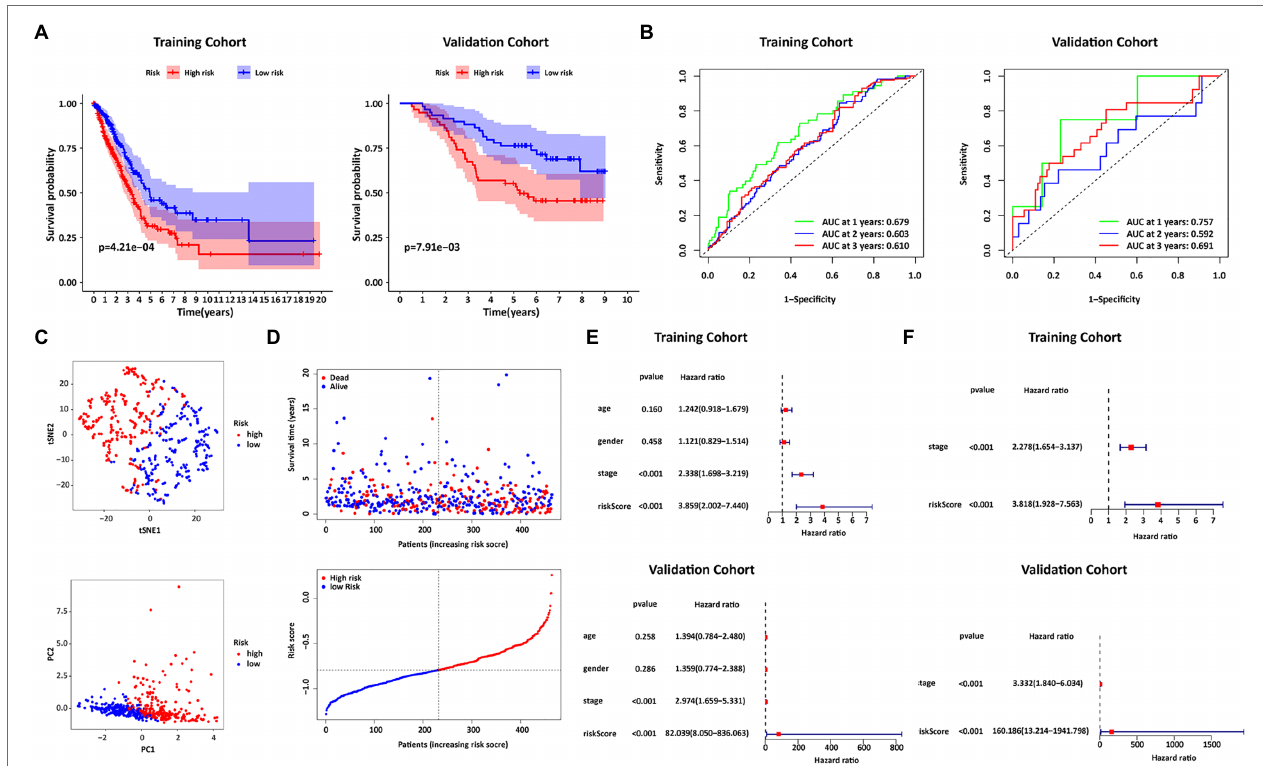
FIGURE 4 | Construction and Validation of the IRGs risk score formula. (A) Kaplan Meier survival curves for the TCGA training cohort and the GEO validation cohort. (B) ROC curves of the IRGs risk score formula in the training and validation cohorts. (C) T-SNE analysis and PCA plot of the training cohort. (D) The risk and survival status plots in the training cohort. (E) Forest plot from the univariate Cox regression analysis in the training and validation cohort. (F) The results of multivariate analysis regarding OS in the training and validation